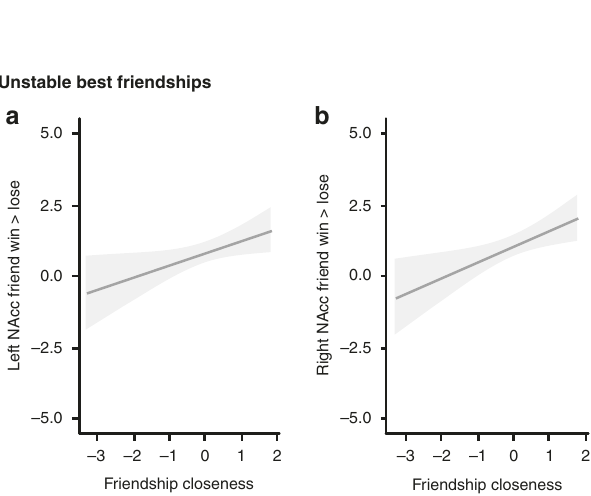
Fig. 2 Relation between vicarious reward-related NAcc activity and friendship closeness in adolescents with unstable best friendships. Mixed-models ( n = 74, 135 data points) were run with the following outcome variables. a Left NAcc. b Right NAcc. The gray ribbon shows the 95% con fi dence interval, and the solid line the predicted p = 0.75 and 0.20 for positive and negative friendship quality, respectively; right NAcc: p = 0.37, and 0.87 for positive and negative friendship quality, respectively) and unstable friendships (left NAcc: p = 0.84 and 0.07 for positive and negative friendship quality, respectively; right NAcc: p = 0.77 and 0.06 for positive and negative friendship quality, respectively).